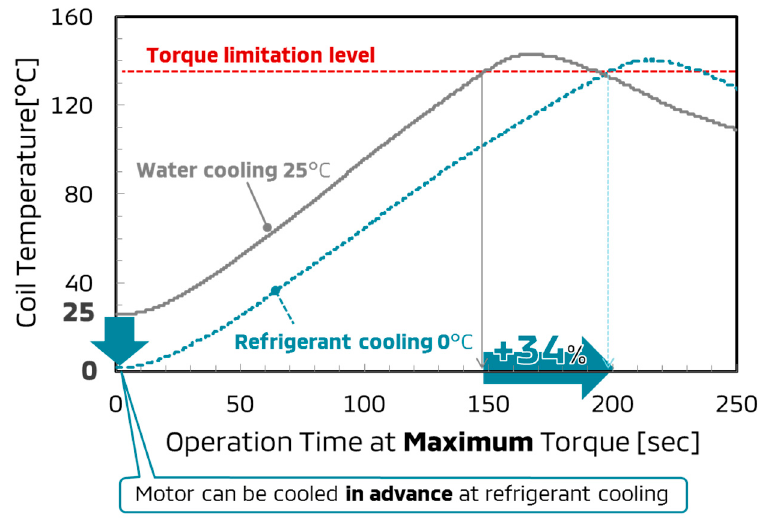
Figure 10. Coil temperature vs operation time at the maximum torque in case that refrigerant cooling cooled the motor in advance.